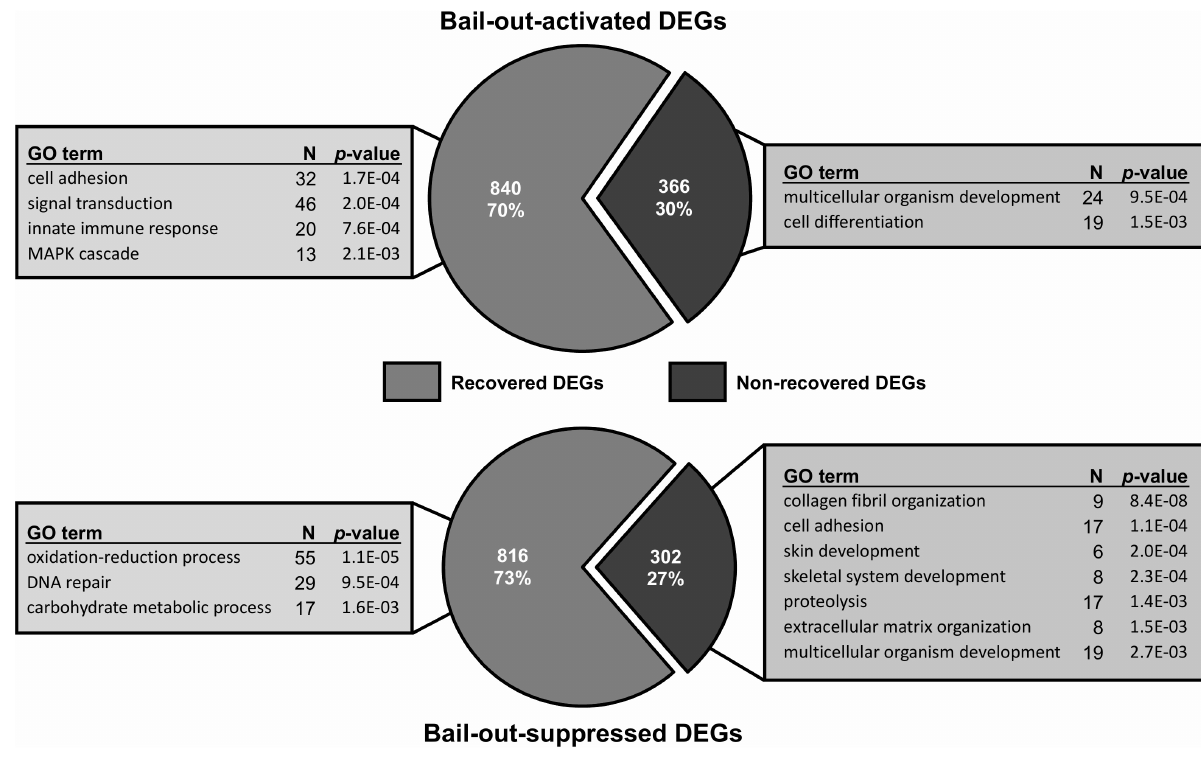
FIGURE 5 | Recovery of bail-out-induced genetic changes in degenerated polyps at day5 post-bail-out. Numbers of differentially expressed genes (DEGs) up- or down-regulated during polyp bail-out and significantly overrepresented gene ontology (GO) categories ( p < 0.005) are displayed. The number of unique genes in each GO category is